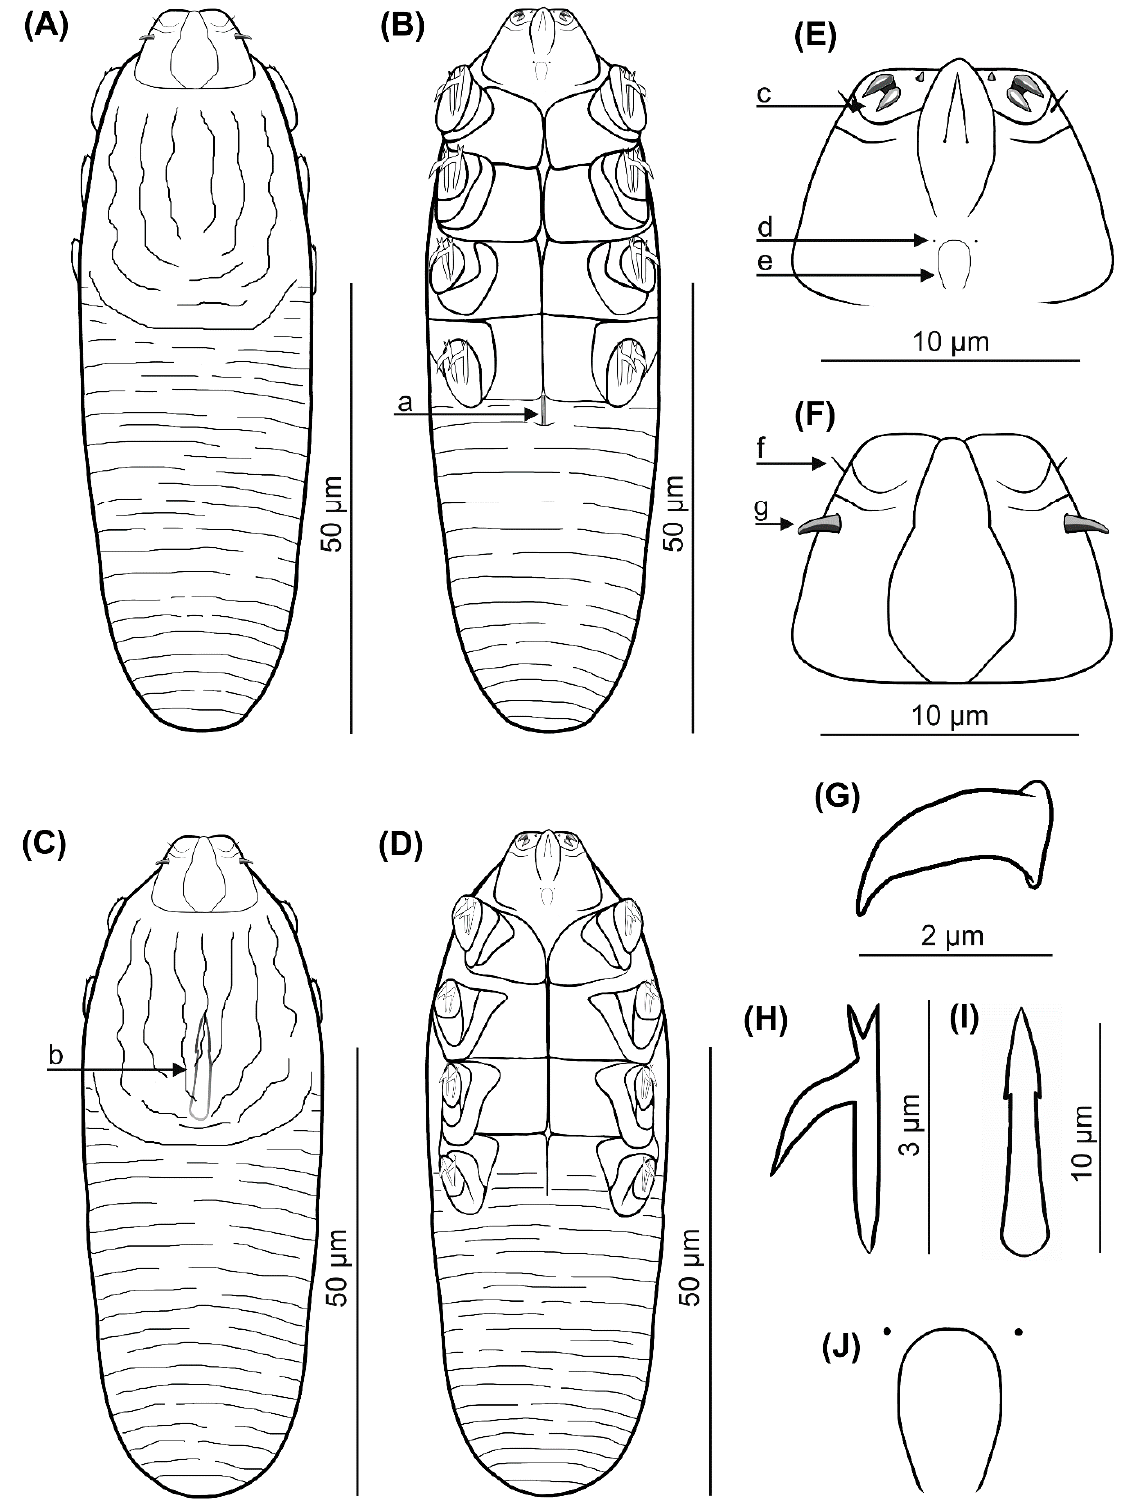
Figure 1. Demodex pusillus sp. nov.: female, dorsal view ( A ), female, ventral view ( B ), male, dorsal view ( C ), male, ventral view ( D ), gnathosoma, female, ventral view ( E ), gnathosoma, female, dorsal view ( F ), supracoxal spine, lateral view ( G ), claw on the leg ( H ), aedeagus ( I ); pharyngeal bulbs with subgnathosomal setae ( J ); a: vulva, b: aedeagus, c: spines on palps, d: subgnathosomal seta (seta n ), e: pharyngeal bulb, f: seta v”F , g: supracoxal spine (seta elc.p ).